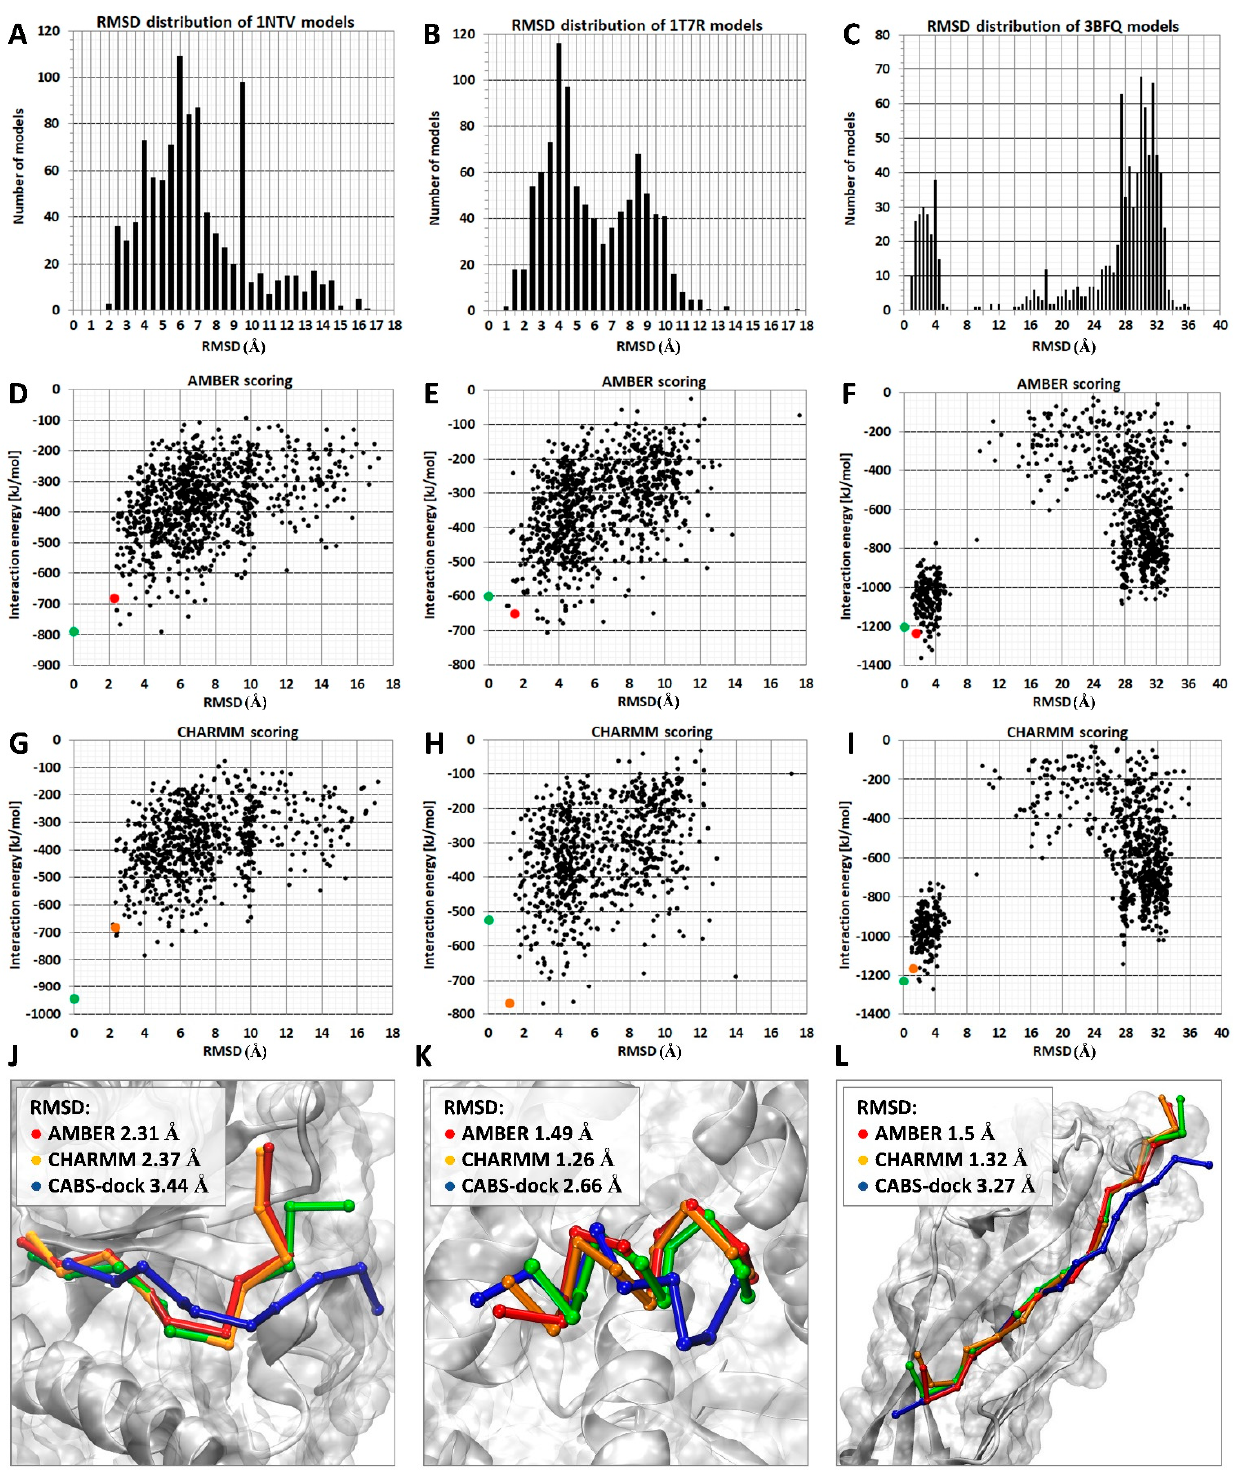
Figure 2. Examples of the MD-based scoring results. Ranking results for three complexes, 1ntv, 1t7r, and 3bfq, are shown. In panels ( A – C ) histograms of RMSD values calculated for model set derived from CABS-dock benchmark [20] are shown. Plots presenting RMSD values and corresponding interaction energy values calculated using AMBER and CHARMM force fields are shown in panels ( D – I ). Panels ( J – L ) show visualization of the best model found in the set of top 10 models for each of three complexes: CABS-dock model—color blue, the model scored using AMBER—color red, the model scored using CHARMM—color orange. For comparison, the crystal structure of peptide ligand is also displayed—color green.